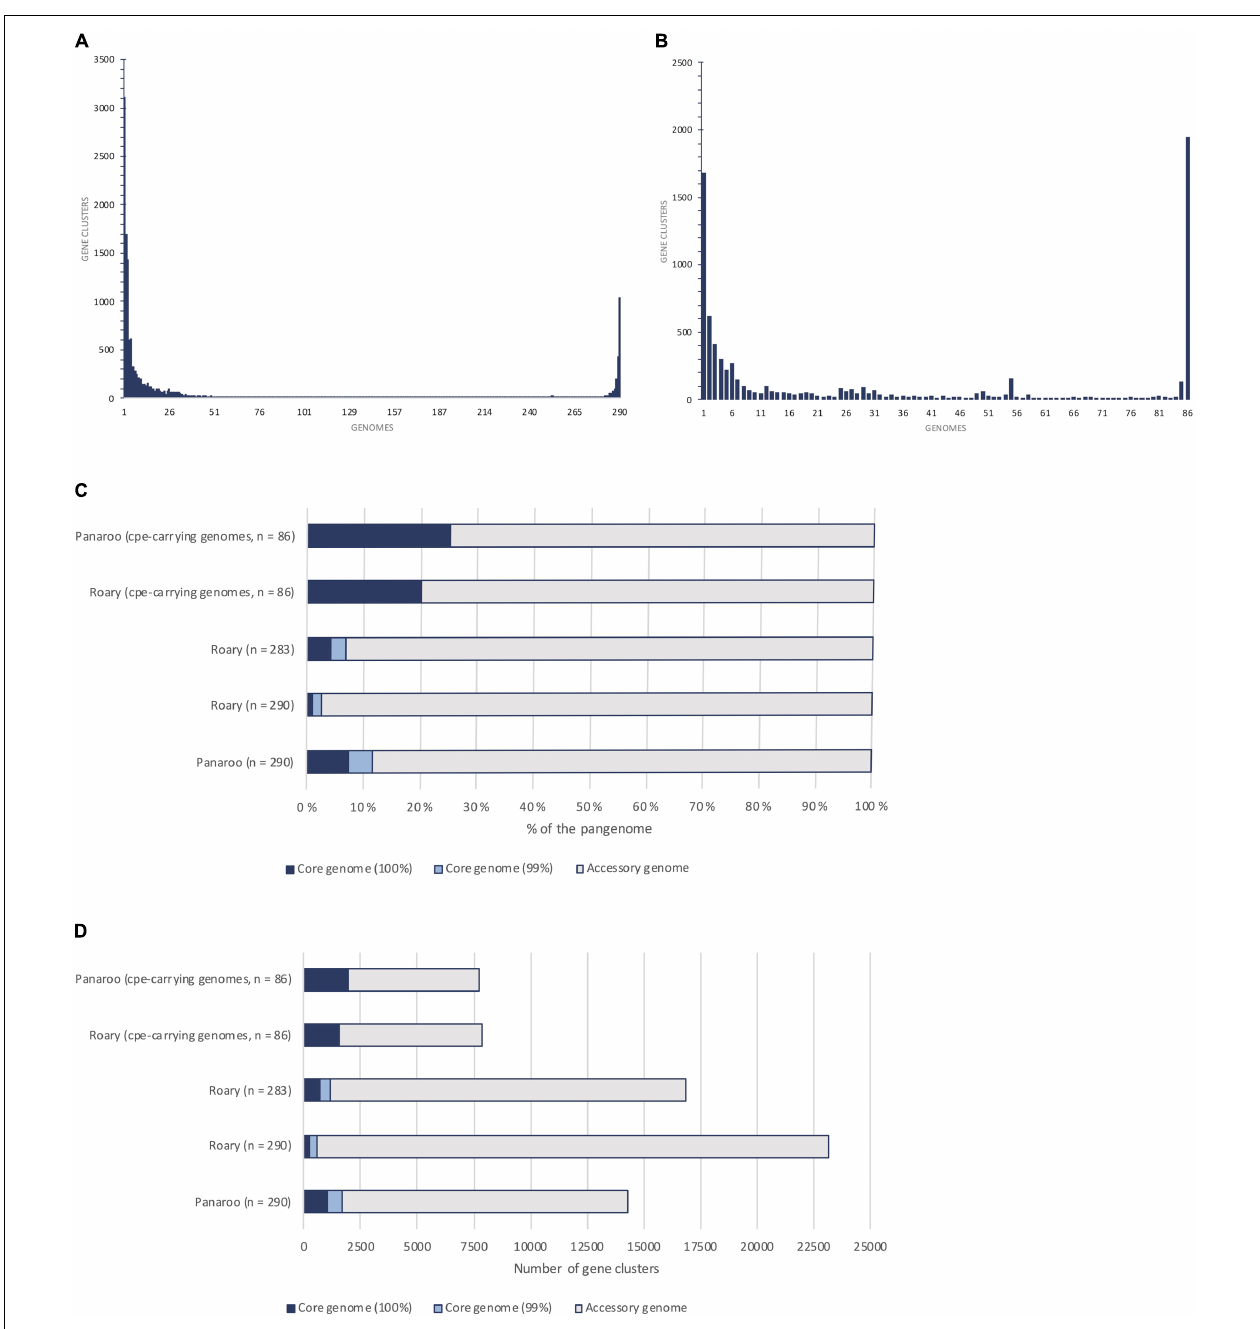
FIGURE 2 | Pangenome and core genome comparison of Clostridium perfringens using Roary and Panaroo pipelines. (A,B) show the frequency of gene clusters within the pangenome, i.e., how many genomes were the gene clusters present in. (A) shows the gene cluster size distribution within the pangenome of 290 strains and (B) the gene distribution within the pangenome of 86 cpe -carrying isolates. Both (A,B) are based on Panaroo results. Chart (C,D) visualize the proportion of the predicted core genome to the accessory genome in different analyses based on the percentage (C) and the actual number of genes (D)